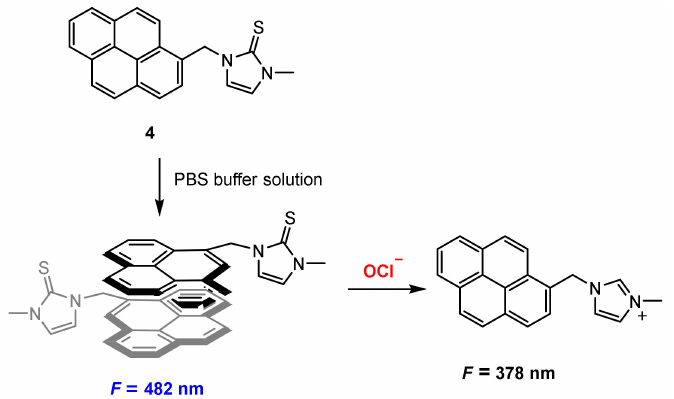
Figure 10. Chemical structure of probe 4 and its excimer response to OCl − . In PBS buffer solution (pH 7.4), probe 4 exhibited a strong excimer fluorescence at 482 nm. The addition of OCl − to the solution of probe 4 resulted in a decrease of the fluorescence at 482 nm and appearance of monomer fluorescence at 378 nm. The ratio of the fluorescence intensities ( F 482 / F 378 ) was reduced 124-fold when OCl − (0–40 µ M) was added. The probe exhibited good sensitivity and the detection limit is calculated to be 0.2 µ M. Ratiometric tracking of endogenous OCl − was conducted in stained Raw 264.7 live cells with probe 4 using two-photon excitation. Endogenous OCl − was produced with ROS inducers (LPS: 100 ng/mL, IFN- γ : 50 ng/mL, and PMA: 10 nM). Upon excitation with 730 nm, the average fluorescence intensity of the stained cells was reduced, and the ratio of F green / F blue is calculated to be 2.7 (Figure 11c,f). However, the ratio of F green / F blue increased to 3.9 when inhibitors such as 4-aminobenzoic acid hydrazide (4-ABAH) [38] or flufenamic acid (FFA) [39] were added (Figure 11d–f). The results suggest that 7 could be applicable to ratiometric fluorescence imaging of OCl − in live cells.